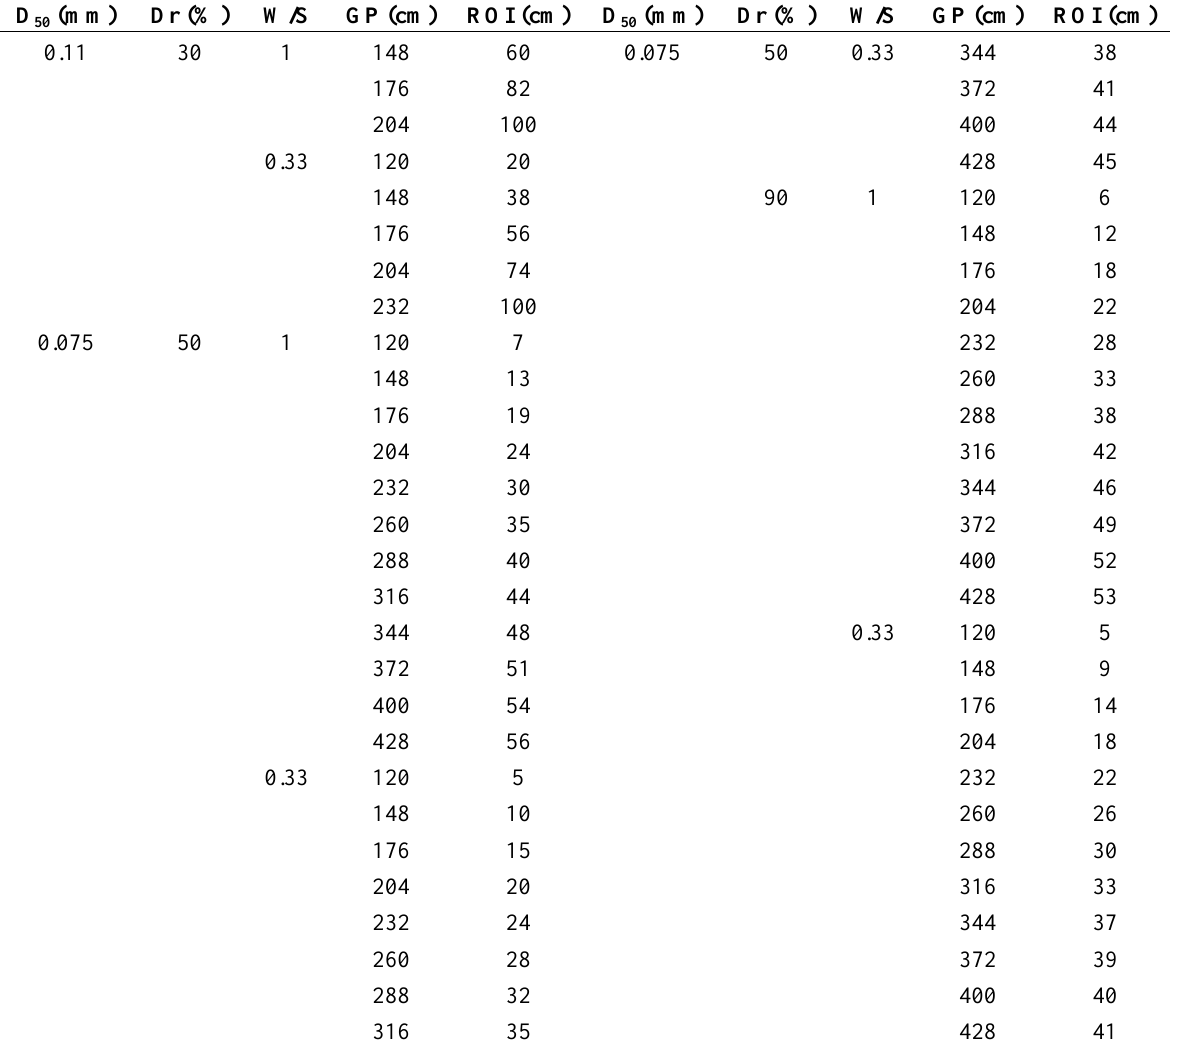
Table 1. Experimental data.